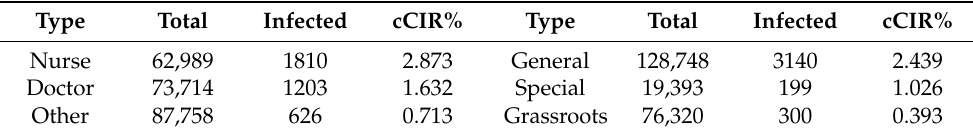
Table 3. Statistics of health care infection in Hubei province.